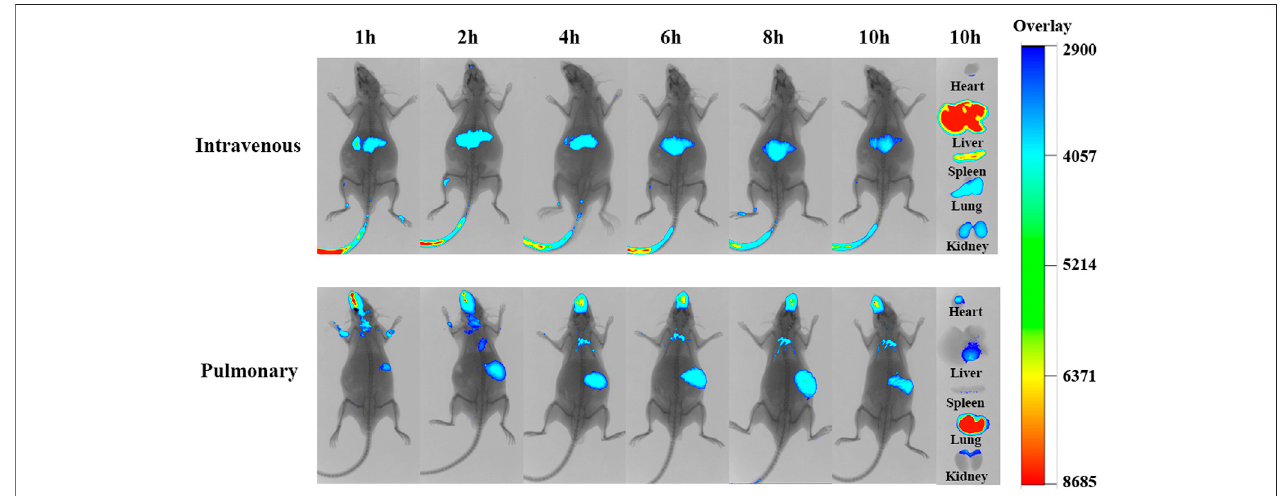
FIGURE 8 | Fluorescence distribution in ICR mice after tail vein injection of DiR-PSL and pulmonary administration of DiR-PSL (0.25 mgkg -1 ) ( n = 6).